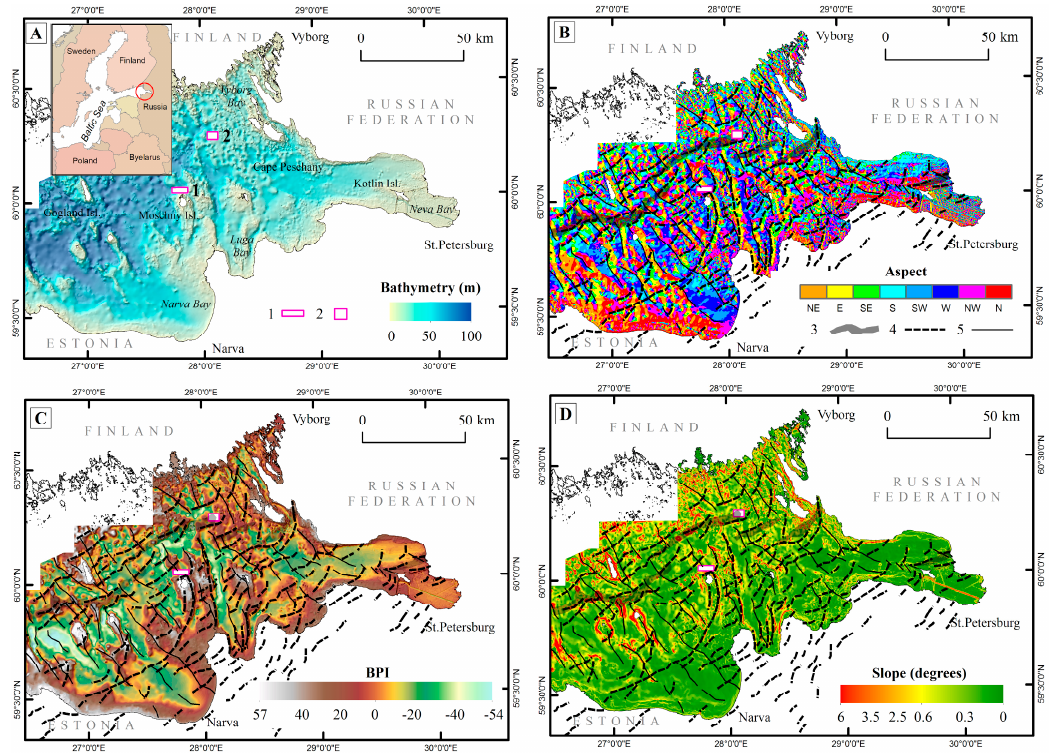
Figure 1. Broad scale models of the Eastern Gulf of Finland bottom relief. ( A ) bathymetry. Bottom relief is relatively shallow. Depths gradually rise from the east (2–5 m in Neva Bay) to west (70–80 m around Gogland Island); ( B ) bathymetry aspect map overlayed upon the till surface. The results of analysis facilitated the interpretation of the most probable location of recessional moraines and streamlined moraine features; ( C ) Bathymetric Position Index (BPI); ( D ) slope. Note: most parts of the Eastern Gulf of Finland bottom relief are very smooth (with a slope angle of less than 1°). Maximum slope angles (up to 6°) are observed in the Northwestern part of the study area (blocks 1, 2, key areas selected for multibeam surveys in 2017; 1 = Moschny Island area; 2 = Vyborg Bay area in ( A ); 3 = predicted end-moraine areas according to sub-bottom profile (SBP) data (1986–2000) interpretations (see B for symbol); 4 = assumed till relief features parallel to ice-sheet margin (see B for symbol); 5 = assumed streamlined till relief features (see B for symbol) [16]. The colour ramp has been selected to highlight the main features of the terrain.